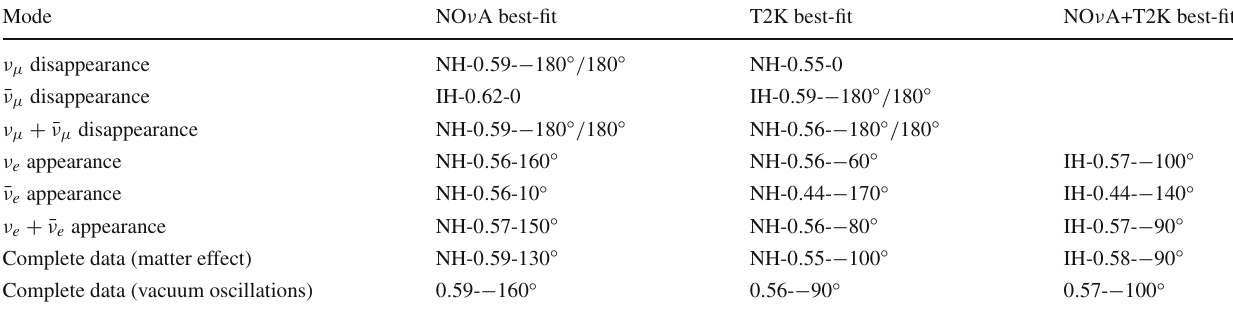
Fig. 8 Allowed region in the sin 2 θ 23 − δ CP plane after analysing NO ν A and T2K complete data set with vacuum oscillation hypothesis. The left (right) panel represents test hierarchy NH (IH). The red (blue) lines indicate the results for NO ν A (T2K) and the black line indicates the combined analysis of both. The solid (dashed) lines indicate the 1 σ (3 σ ) allowed regions. The minimum χ 2 for NO ν A (T2K) with 50 (88) bins is 48.84 (95.85). For the combined analysis, the minimum χ 2 with 138 bins is 147.02